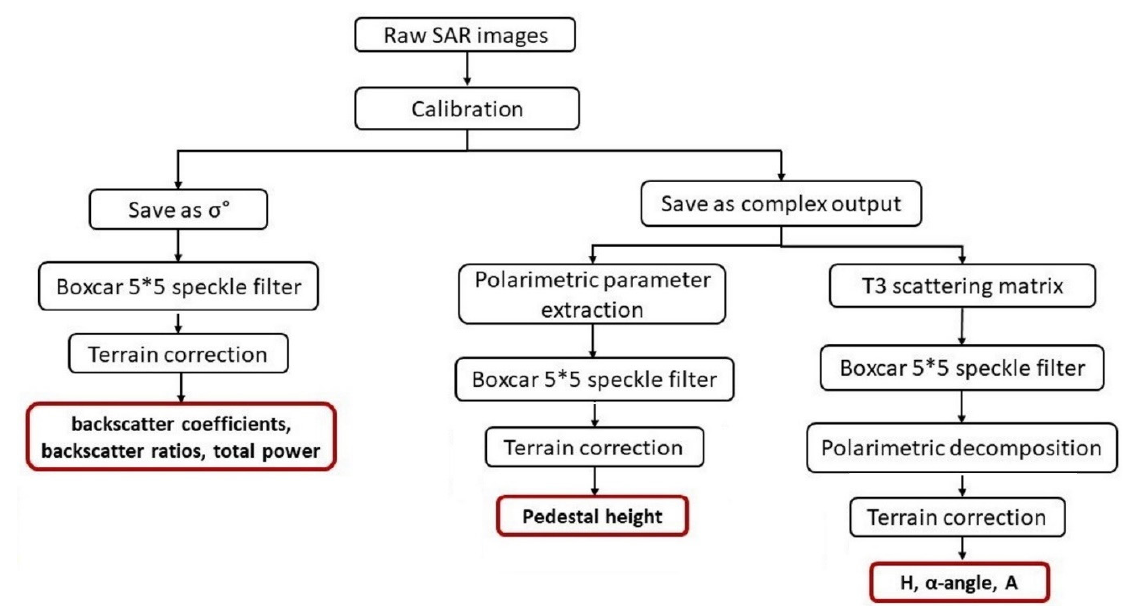
Figure 2. The flowchart of RADARSAT-2 image processing steps.